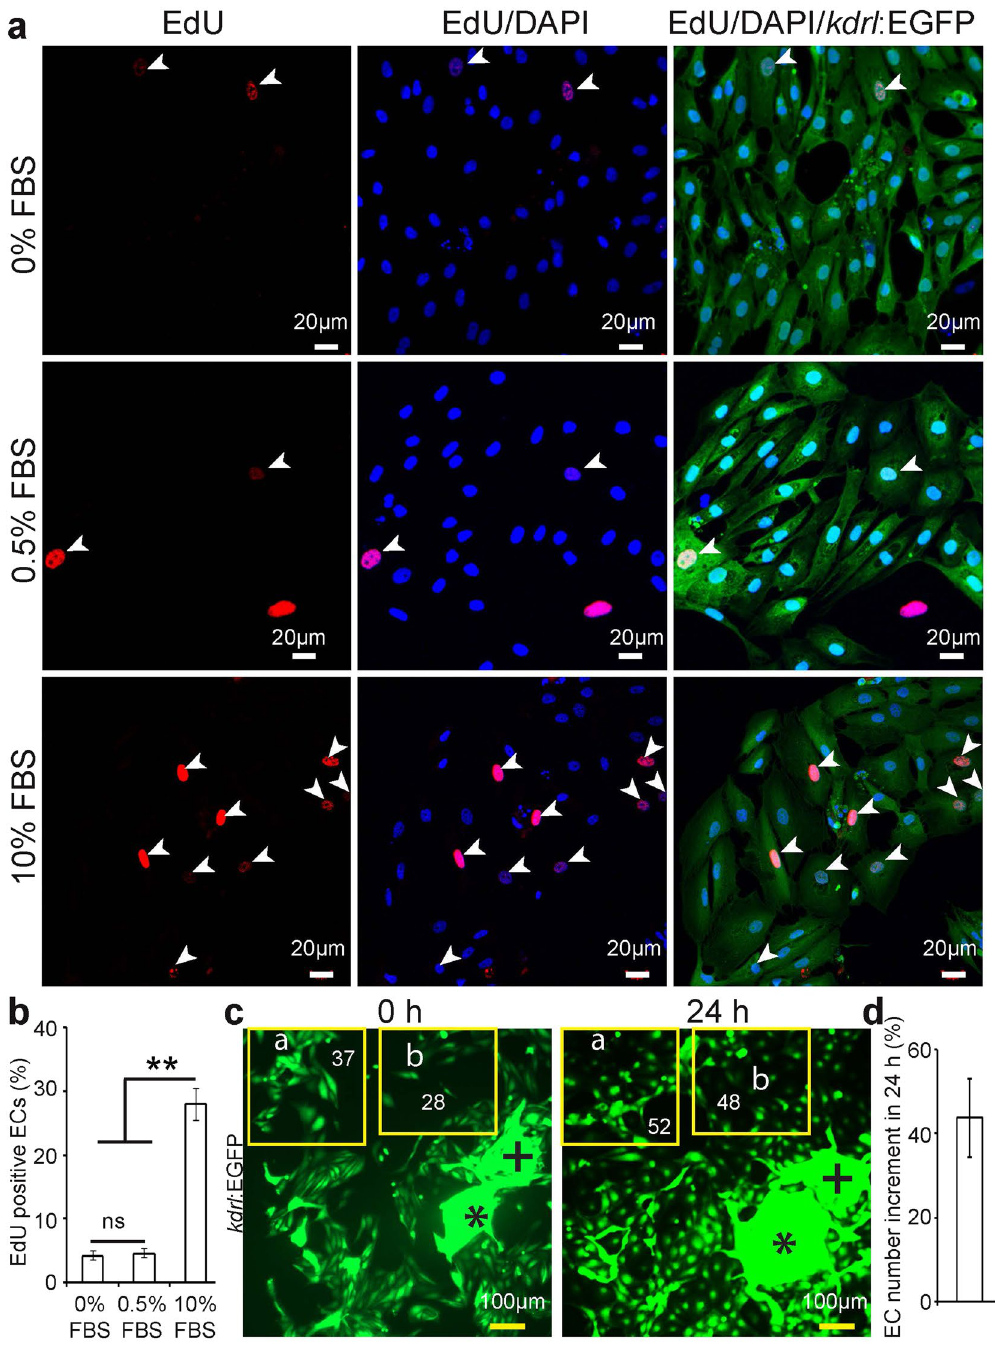
Figure 5. Cardiac endothelial cells proliferate in vitro . 24 h after seeding, ECs were cultured in EGM2 medium supplemented with 0, 0.5 or 10% FBS for 12 h and then analyzed for DNA synthesis using a 12 h pulse of EdU. ( a ) Representative images of endothelial cells stained for EGFP (green), EdU (red), and DAPI (nuclei, blue). White arrowheads point to EdU-positive endothelial cells. ( b ) Quantification of EdU + EGFP + endothelial cells without or with FBS in the culture medium (n = 3, mean ± SEM). P < 0.05 was considered statistically significant. ( c ) Example of cell density experiments. Cells were cultured with 10% FBS, resulting in endothelial cell proliferation. Plus and asterisk symbols are depicting landmarks, showing that pictures were taken from the same region for the cell density analysis. Yellow frames indicate areas of analysis. ( d ) Quantitative analysis of endothelial cell number increment in 24 h (n = 3, mean ± SEM). One way ANOVA followed by Bonferroni’s post-hoc test (GraphPad Prism) was performed to evaluate statistical significance of differences. P < 0.05 was considered statistically significant. ** corresponds to P <